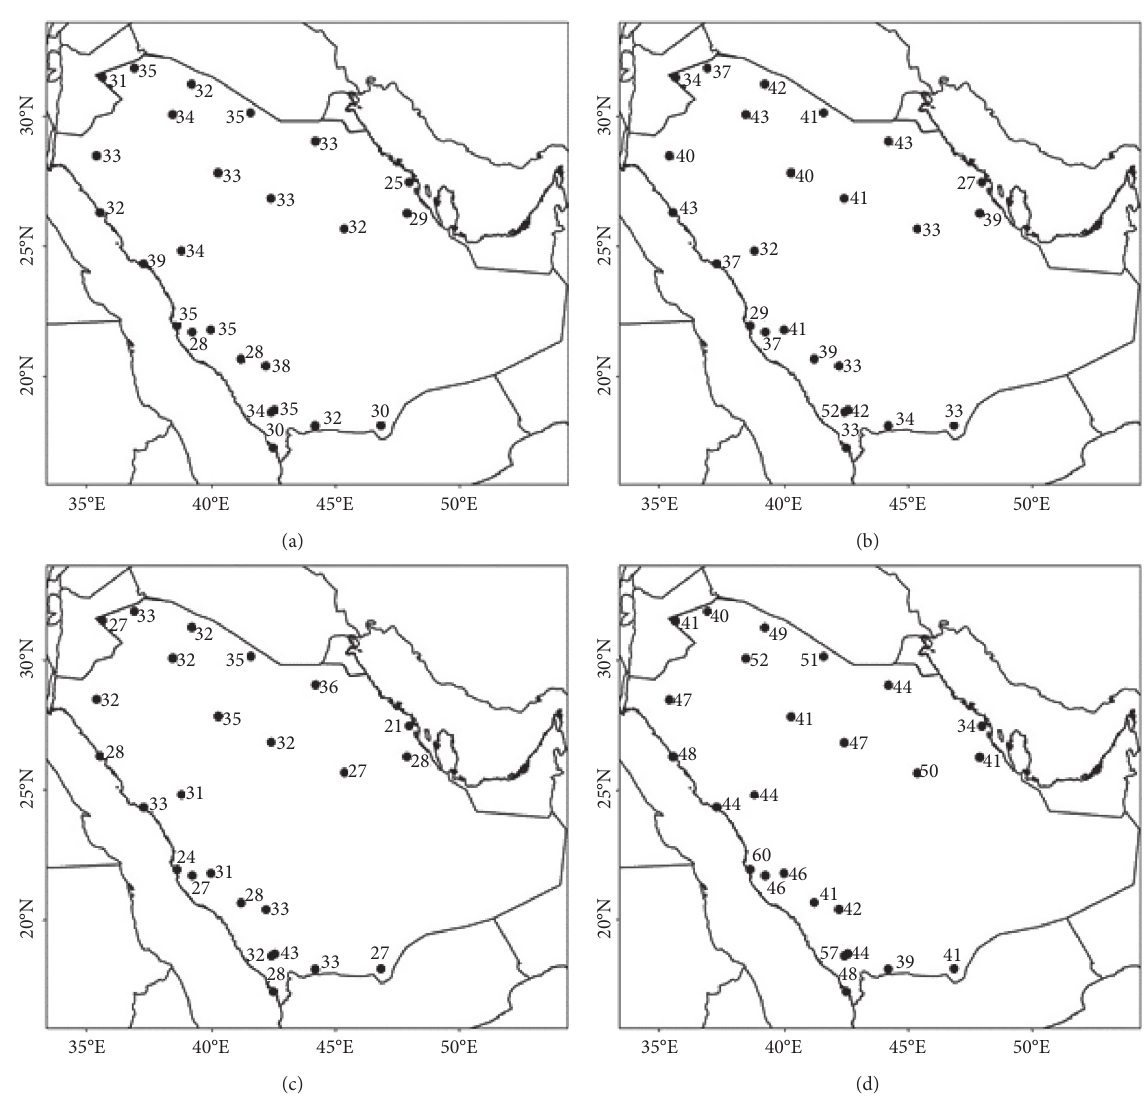
Figure 9: Spatial distribution of annual frequency (days) in (a) cold days (TX10p), (b) warm days (TX90p), (c) cold nights (TN10p), (d) and warm nights (TN90p) for the period 1978–2019. The dots represent the station location, and the numbers are the frequency at each